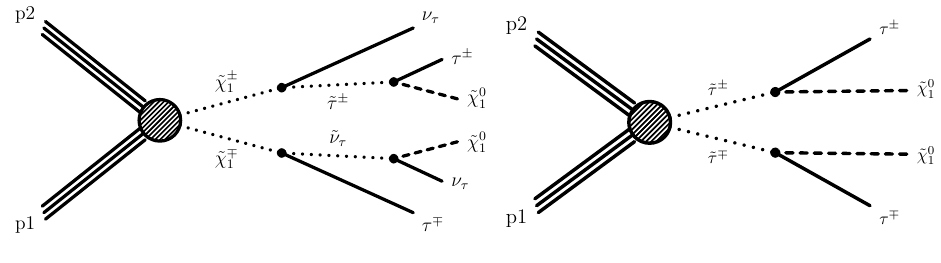
Figure 1 . Schematic production of (cid:28) lepton pairs from chargino (left) or (cid:28) slepton (right) pair